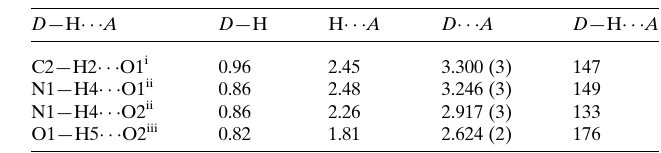
Table 1 Hydrogen-bond geometry (A˚ , (cid:5) ).